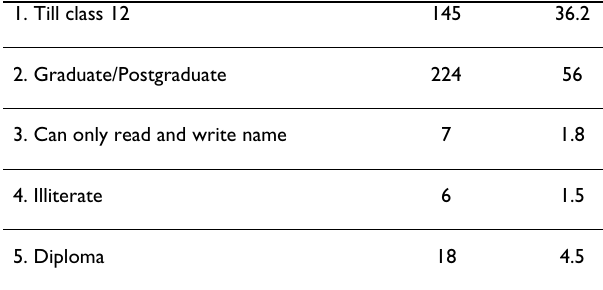
Table 1: Socio demographics of the respondents